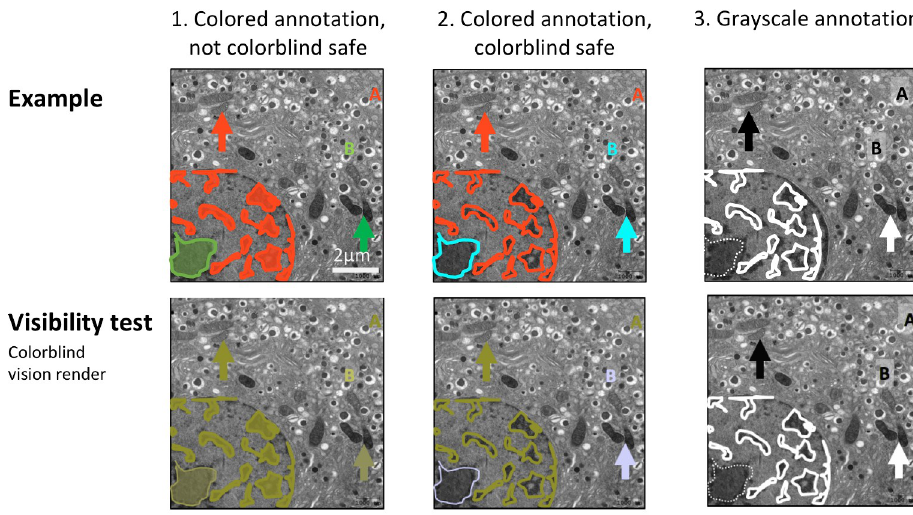
Fig 13. Annotations should be colorblind safe. (1) The annotations displayed in the first image are inaccessible to colorblind individuals, as shown with the visibility test below. This example was created based on problems observed by reviewers. (2, 3) Two colorblind safe alternative annotations, in color (2) and in grayscale (3). The bottom row shows a test rendering for deuteranopia colorblindness. Note that double-encoding of different hues and different shapes (e.g., different letters, arrow shapes, or dashed/nondashed lines) allows all audiences to interpret the annotations. Electron microscope images show mouse pancreatic beta-cell islet cells. All images have the same